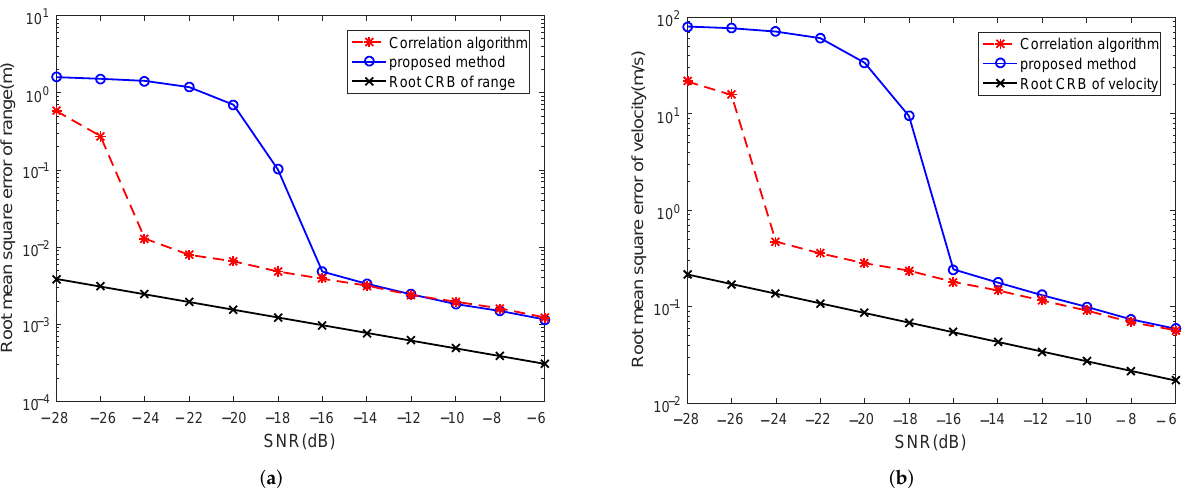
Figure 8. RMSEs of range and velocity estimations. ( a ) RMSEs in the estimation of range. ( b ) RMSEs in the estimation of